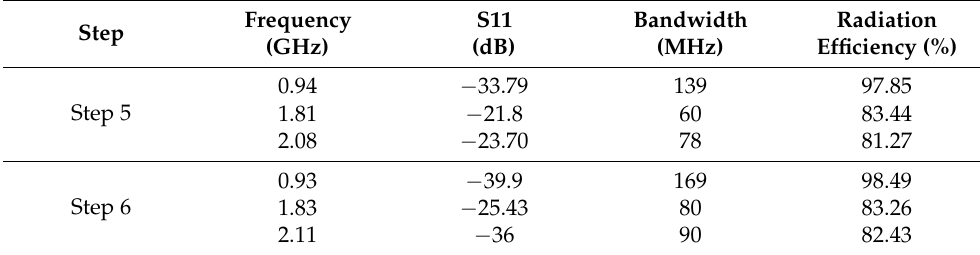
Table 1. Comparison of antenna parameters between step 5 and step 6.